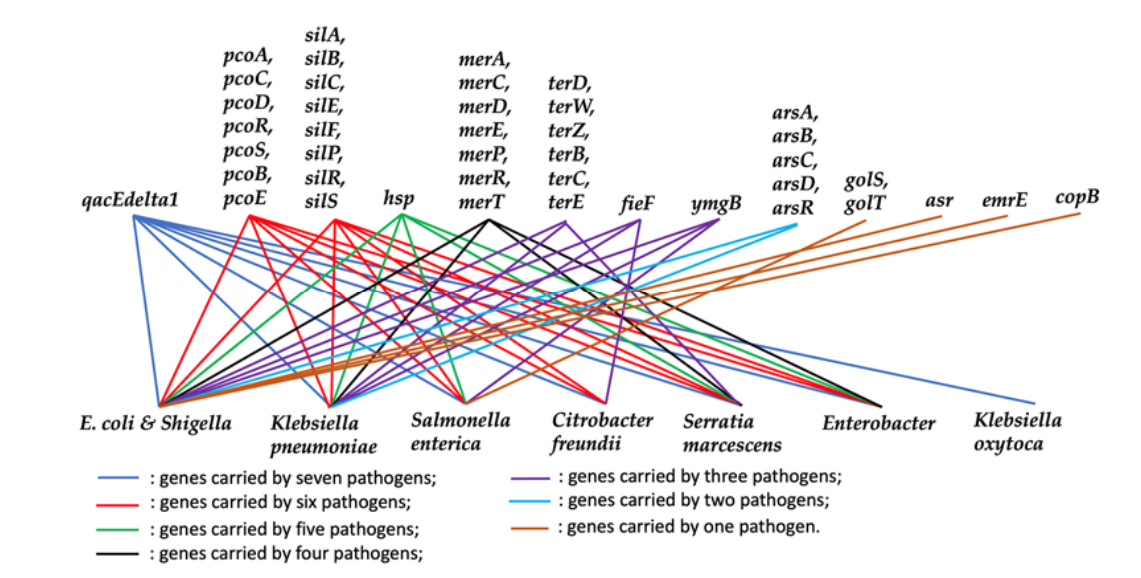
Figure 4. The important stress response genes carried by the important pathogens.